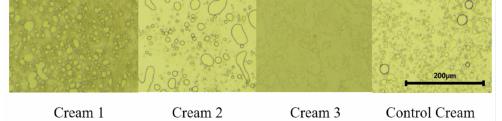
Figure 3. Photomicrographs of creams. Magnification: 40 ×